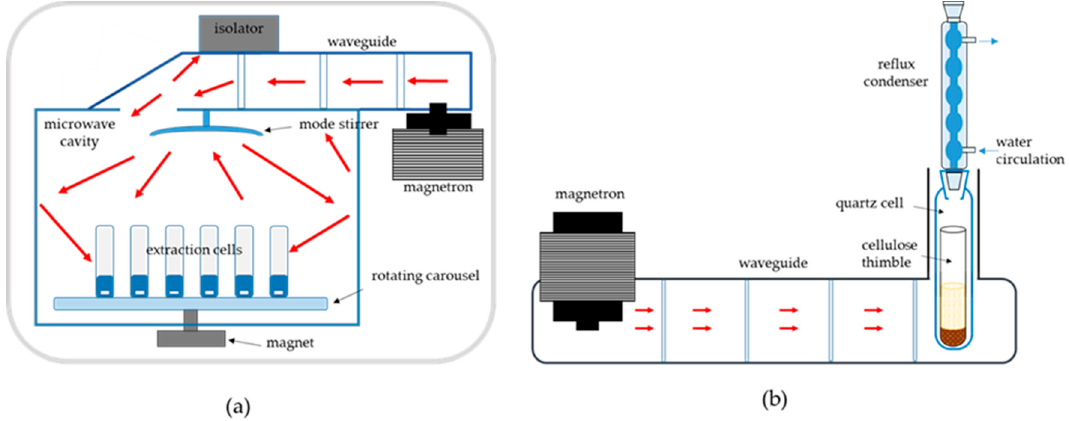
Figure 1. ( a ) Diffused microwave extractor for pressurized microwave-assisted extraction (PMAE); ( b ) Focused microwave extractor for atmospheric pressure microwave-assisted extraction (APMAE).